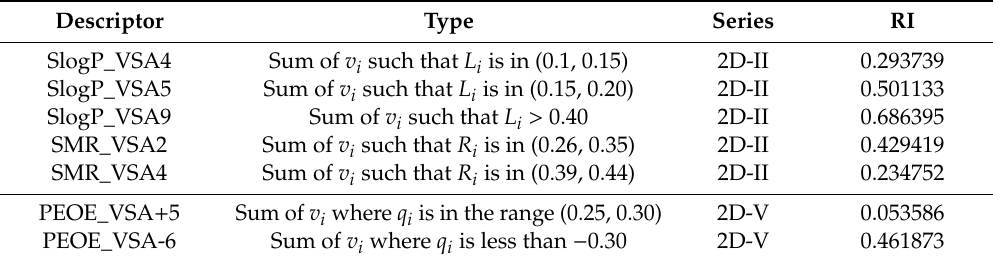
Table 1. Selected two-dimensional (2D) Subdivided Surface Area a and Adjacency and Partial Charge descriptors b and the related relative importance (RI) values based on the developed QSAR